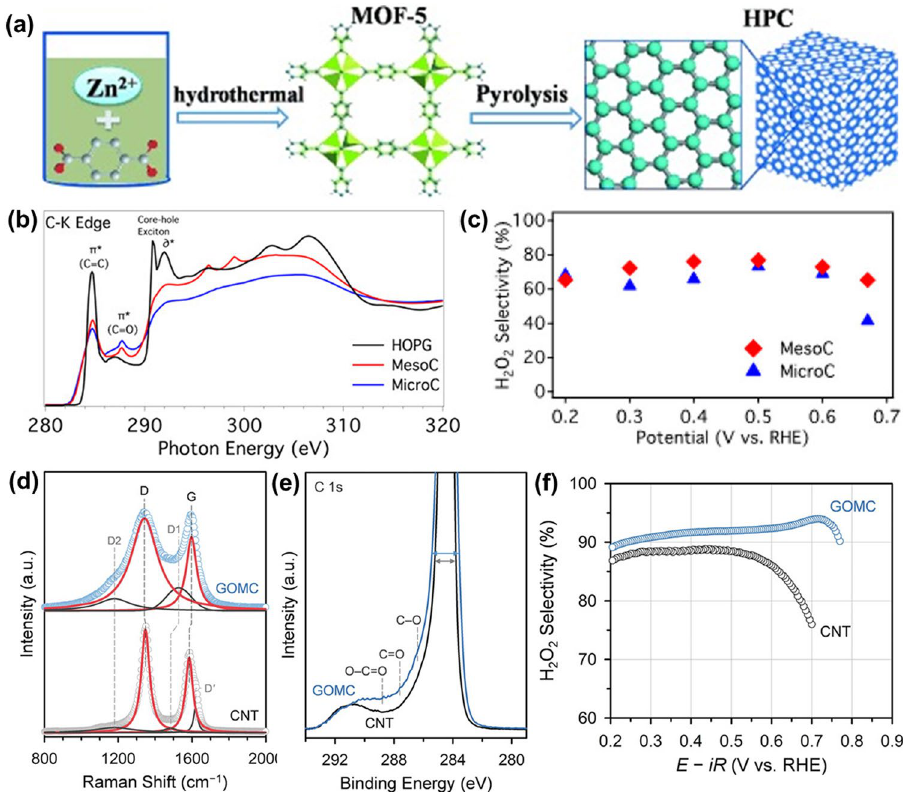
Fig. 14 a Schematic illustration of the synthetic route to HPC. Reproduced with permission from Ref. [215]. Copyright 2015 Wiley–VCH Verlag GmbH & Co. KGaA, Weinheim. b NEXAFS spectra of the C-K edge in HOPG, MesoC and MicroC. c H 2 O 2 selectivity of the MesoC and MicroC electrocatalysts. Reproduced with permission from Ref. [217]. Copyright 2018 American Chemical Society. d Raman spectra, e C 1 s XPS spectra and f H 2 O 2 selectivity of GOMC and CNT. Reproduced with permission from Ref. [218]. Copyright 2019 Wiley–VCH Verlag GmbH & Co. KGaA,